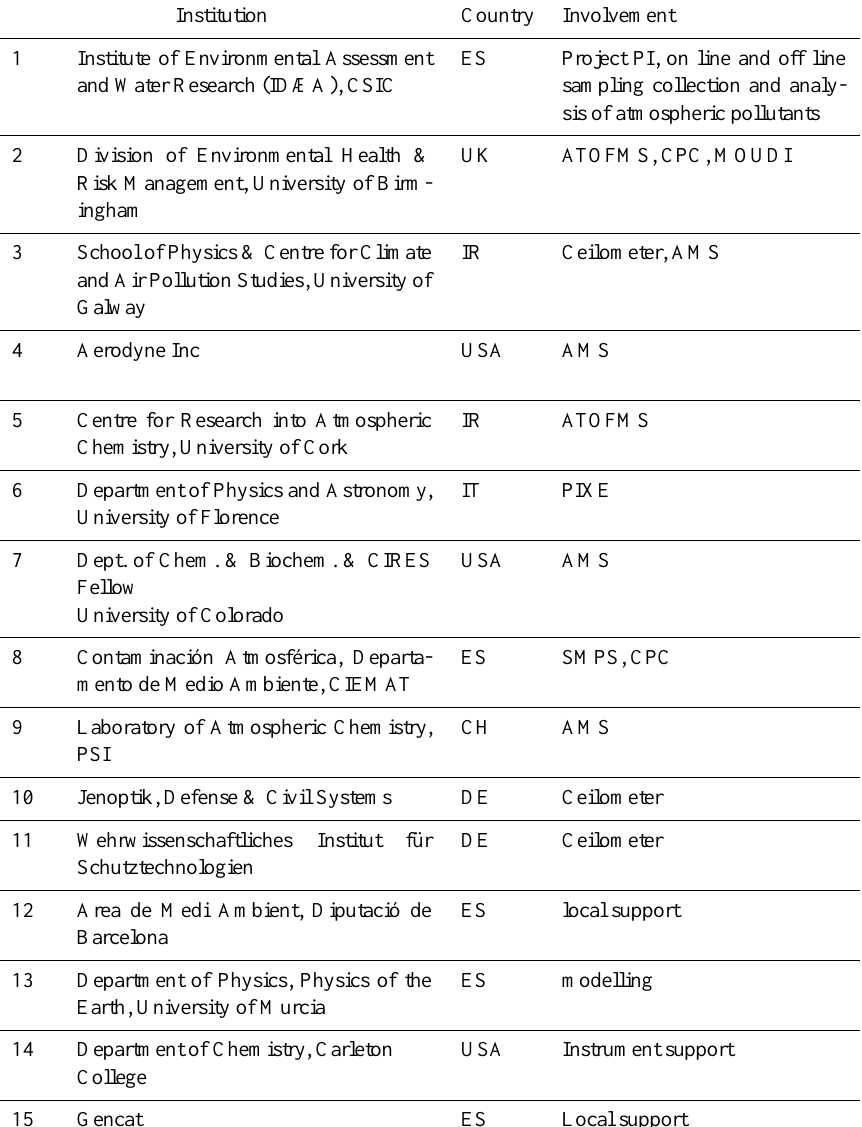
Table 1. Institutions taking part in